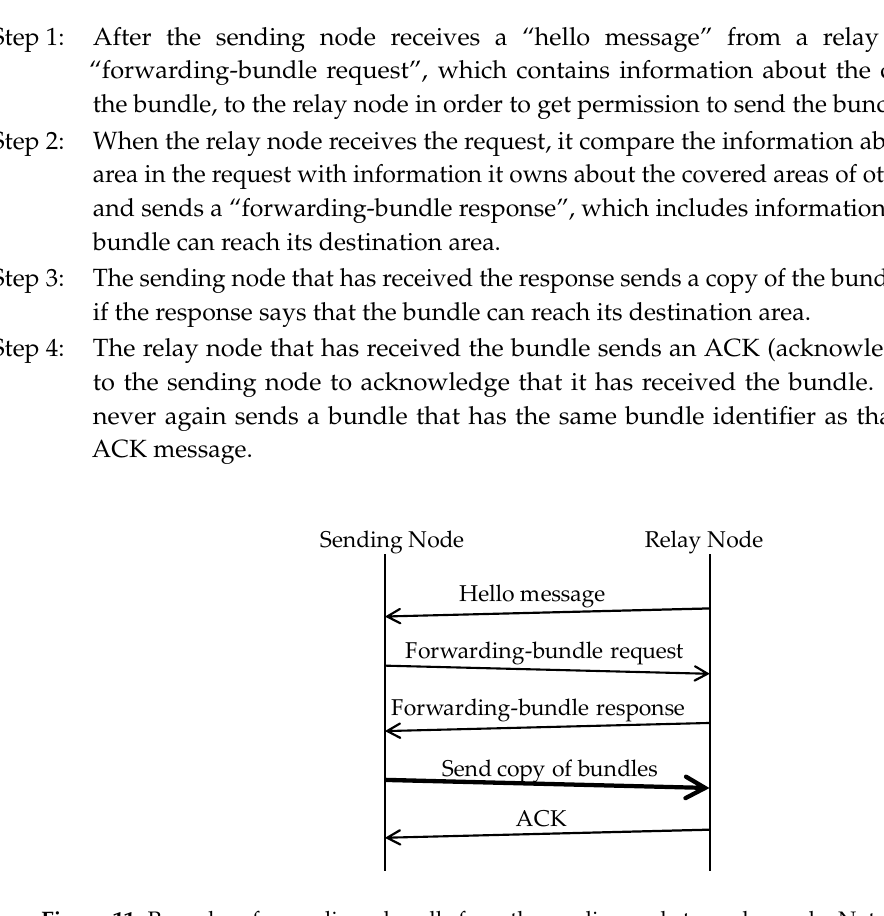
Figure 11. Procedure for sending a bundle from the sending node to a relay node. Note: the bold arrow shows that a bundle copy is sent.